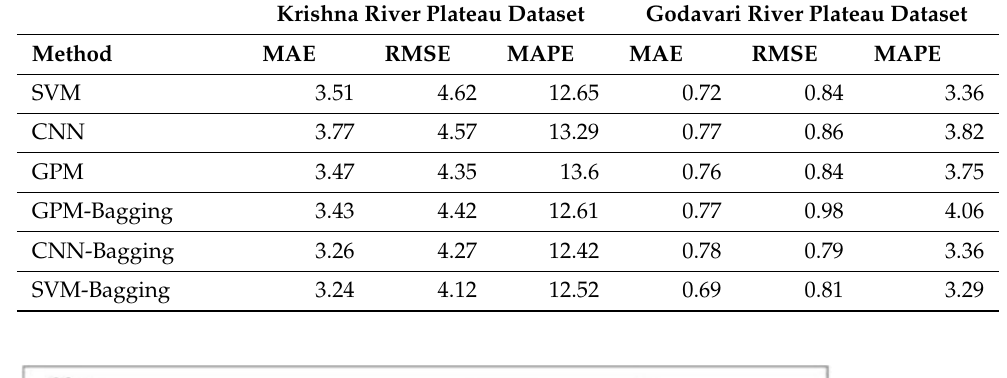
Table 1. Performance of the various classifiers with the proposed model. Krishna River Plateau Dataset